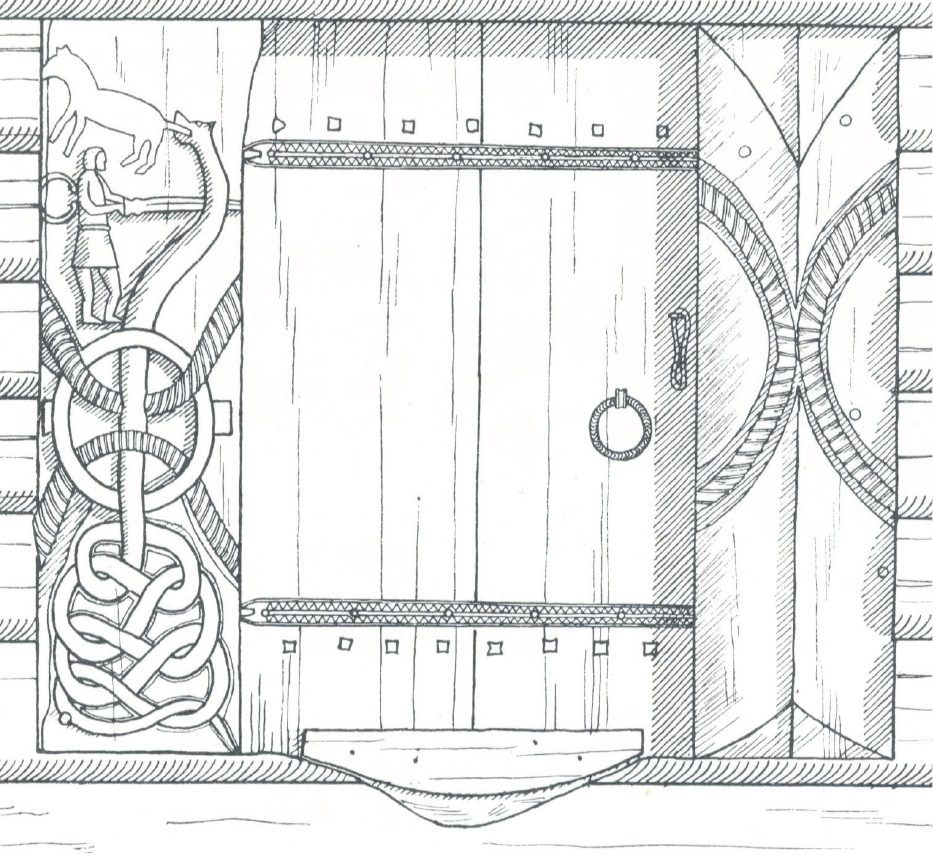
Figure 3: The Lundevall portal portraying Sigurd slaying the dragon. Drawing: P. Gjærder (1952: